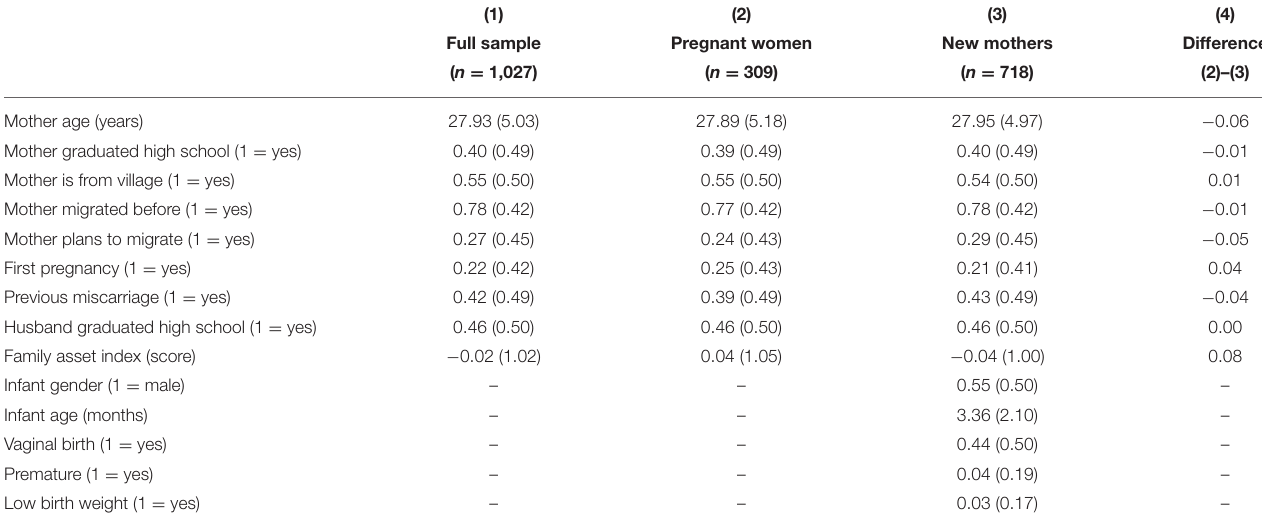
TABLE 1 | Summary statistics for demographic characteristics among full sample and